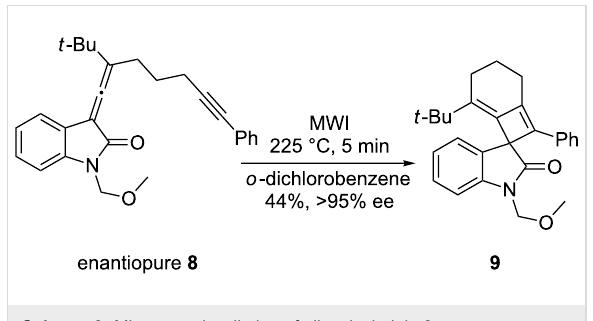
Scheme 3: Microwave irradiation of allenyloxindole 8 .